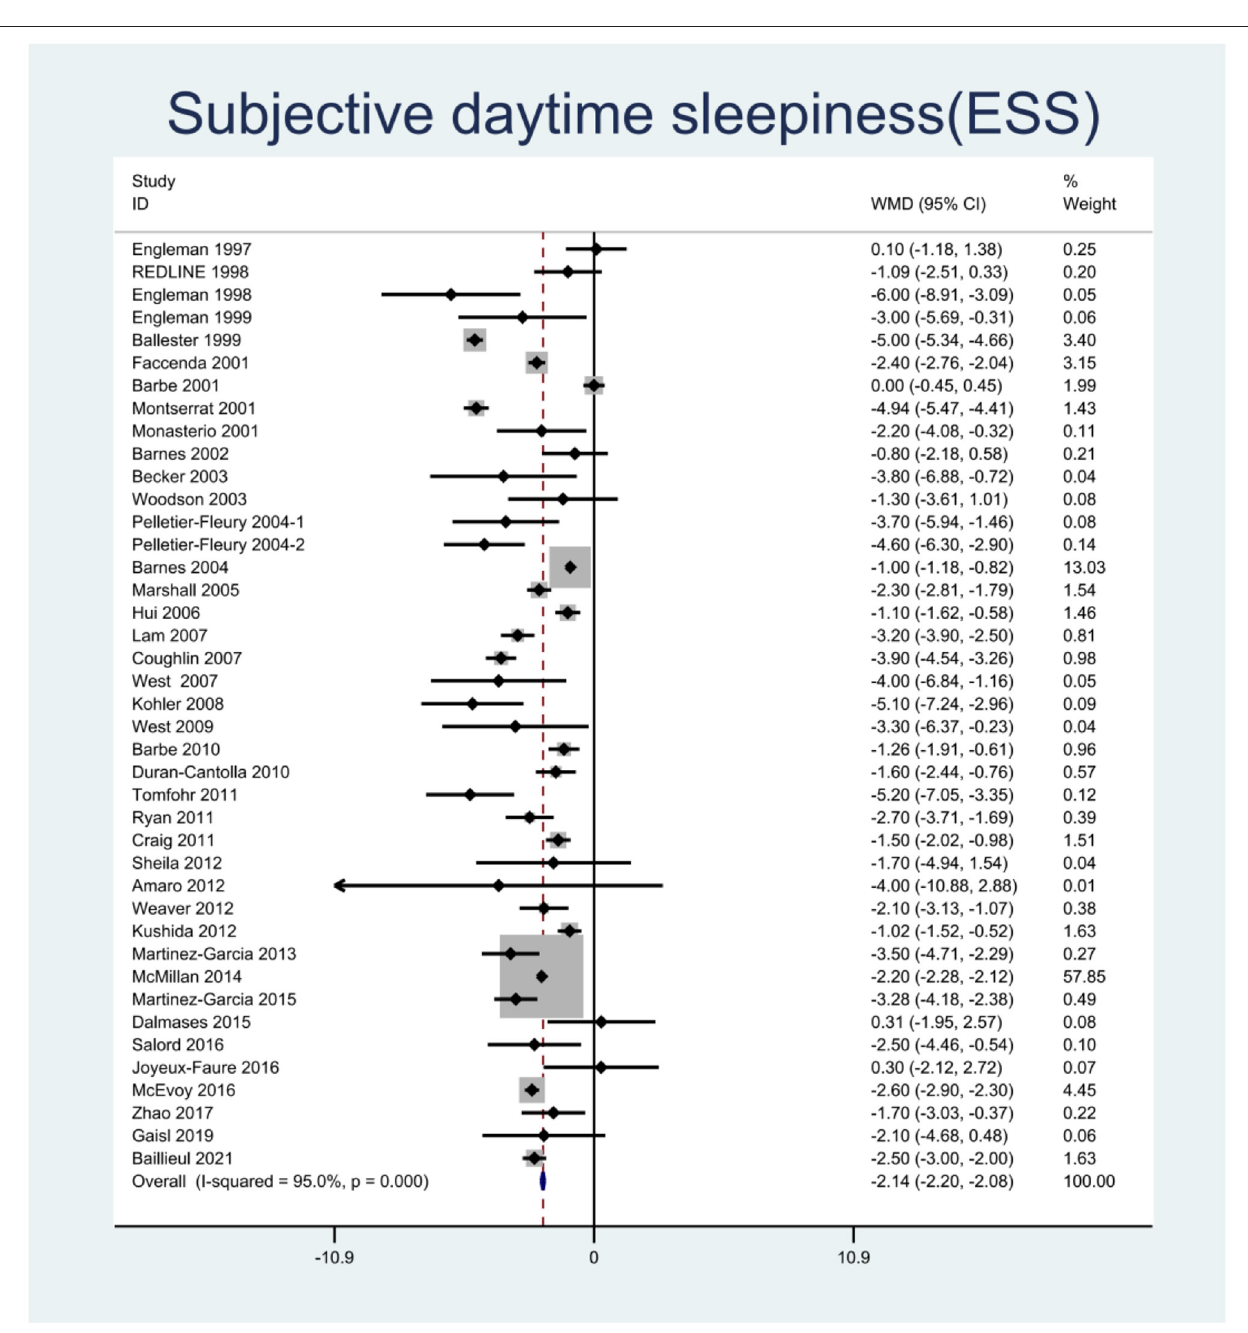
FIGURE 2 | Forest plot showing pooled weighted mean difference (WMD) for Epworth Sleepiness Scale (ESS) in studies on continuous positive airway pressure (CPAP), compared with control